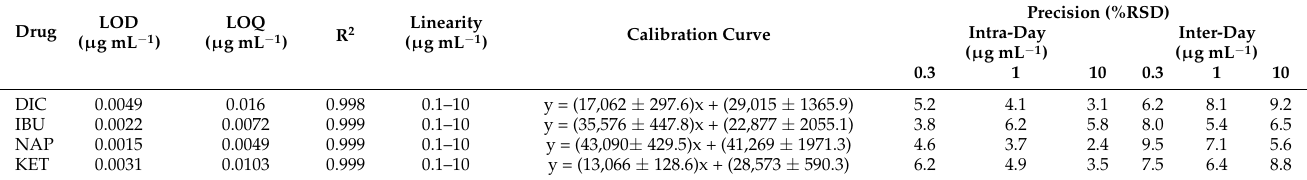
Table 4. Analytical characteristics of FPSE-GC-MS method for NSAIDs.